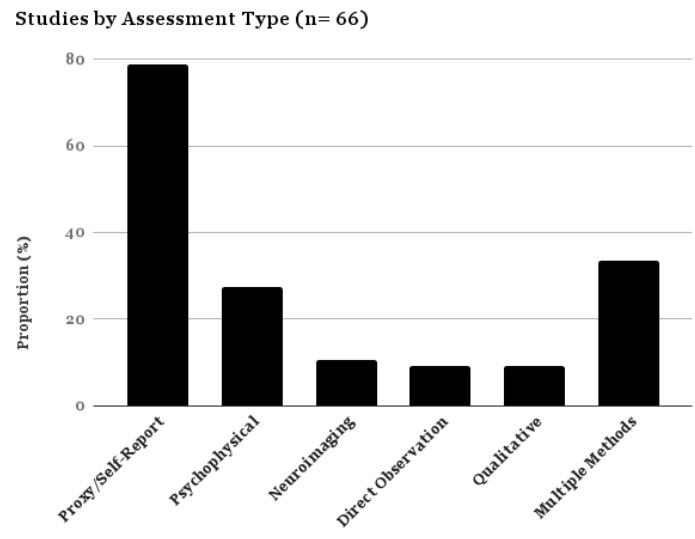
Figure 2. Proportional Table–Studies by Assessment Category.